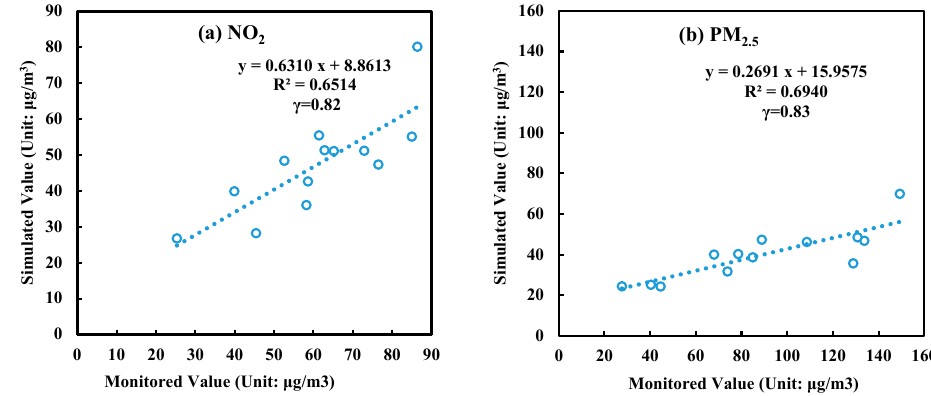
Figure 2. Comparison between simulated values (scenario S0) and monitored values .